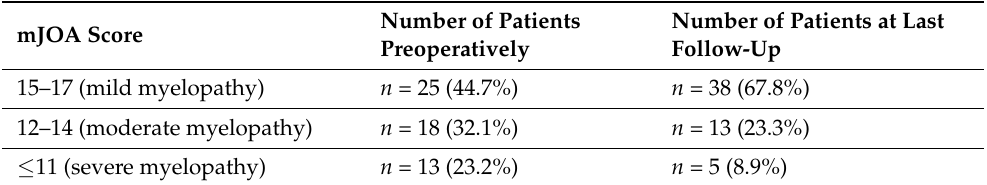
Preoperatively Last Follow-Up p Value Mean ROM [ ◦ ] index